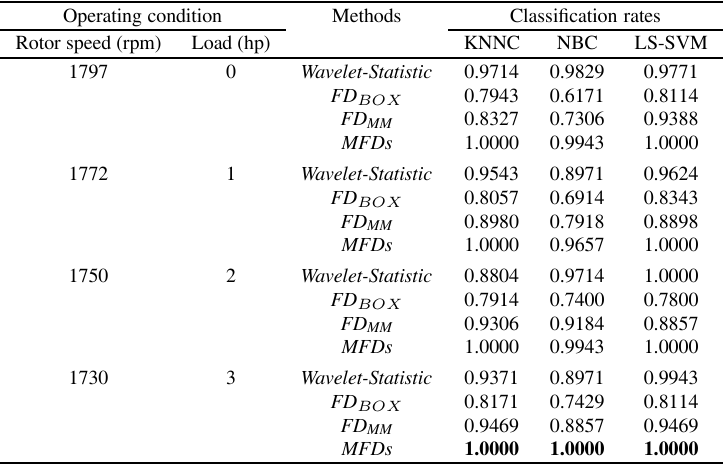
Performances of Wavelet-Statistic, FD BOX , FD MM and MFDs using the three classi fi ers on four bearing